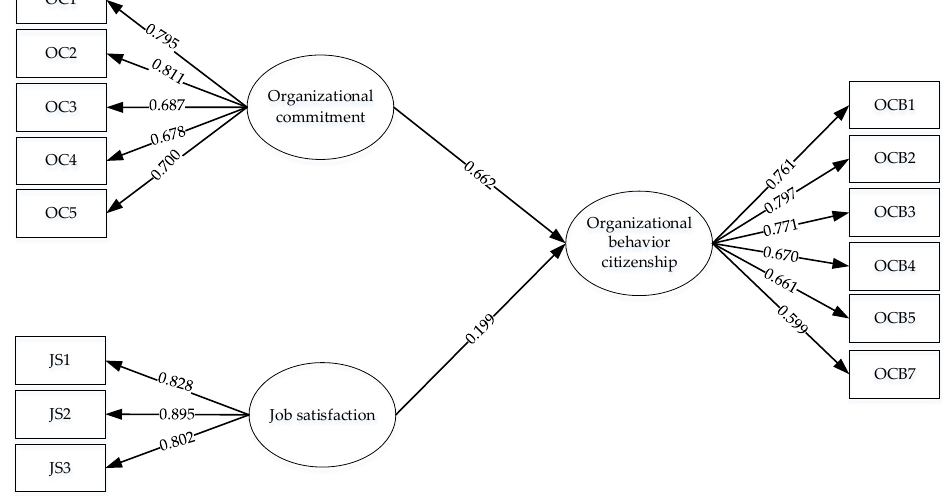
Scheme 3. Influence of appraisal problems on organizational commitment